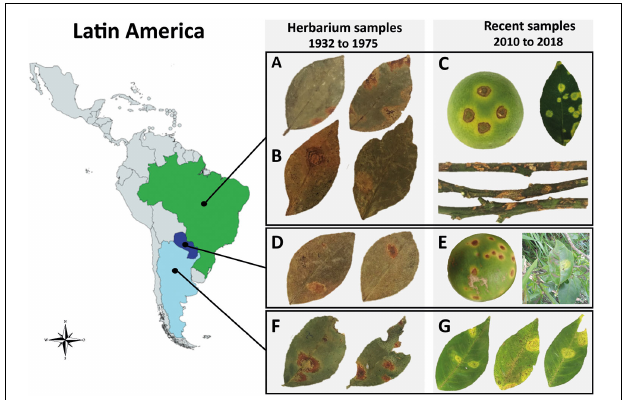
FIGURE 1 | Symptoms of citrus leprosis (CL) disease and place of collection of the infected Citrus spp. samples across Latin America. (A,B,D,F)